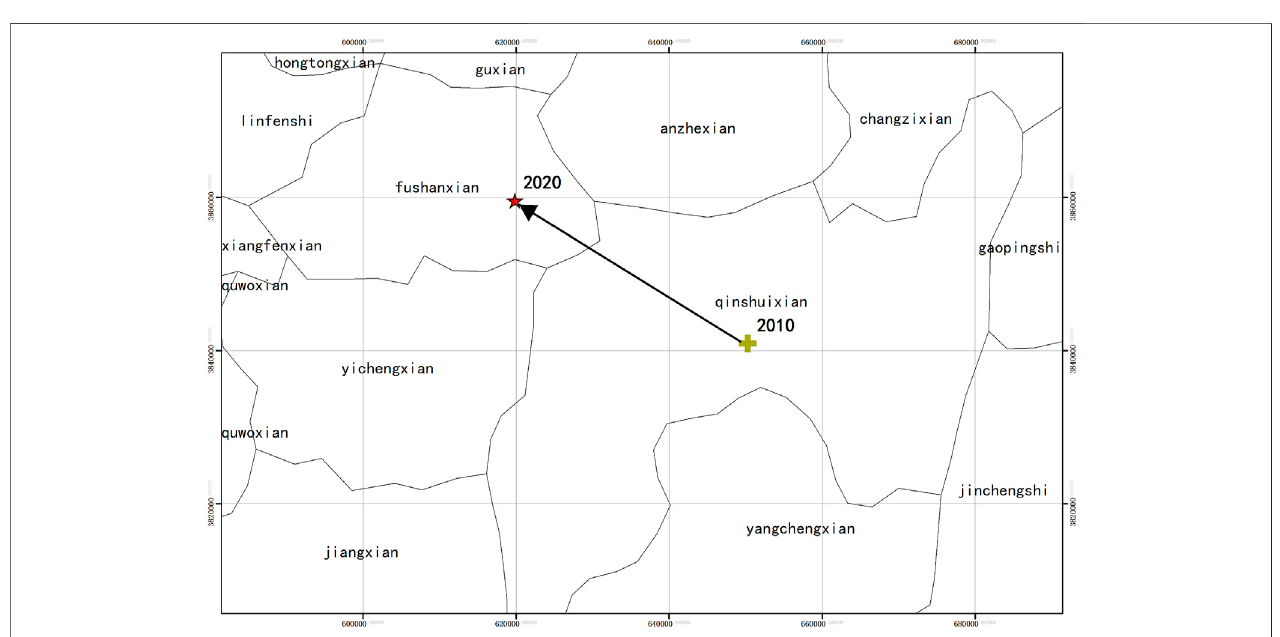
FIGURE 1 | The distribution of cultivated land center of gravity in China during 2010 – 2020.